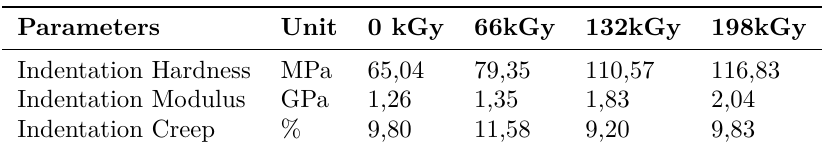
Table 3. Indentation parameters.